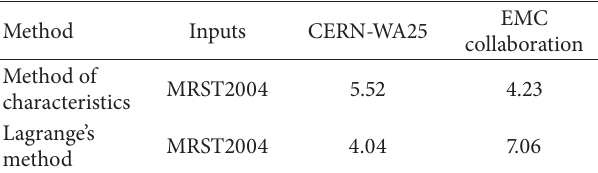
Table 2: 𝜒 2 /d.o.f. for (24) and